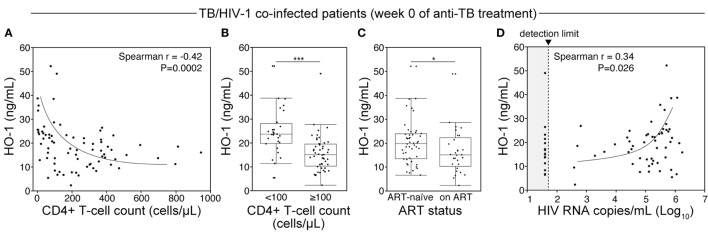
HIV-1 coinfection and degree of immunosuppression relates to heme oxygenase-1 (HO-1) concentrations in plasma from tuberculosis (TB) patients prior to antitubercular treatment. (A) Spearman correlation analysis of HO-1 levels in plasma by CD4+ T-cell counts in HIV-infected patients before initiation of antibubercular therapy. (B) HIV-infected patients were further classified based on CD4+ T-cell counts and HO-1 levels. (C) HO-1 levels were also compared between antiretroviral therapy (ART)-naïve patients and those who were on ART before TB treatment. In panels (B,C), data were compared using the Mann–Whitney U test. (D) Spearman correlation analysis of HO-1 levels in plasma with HIV viral load at pretreatment in HIV-infected patients.